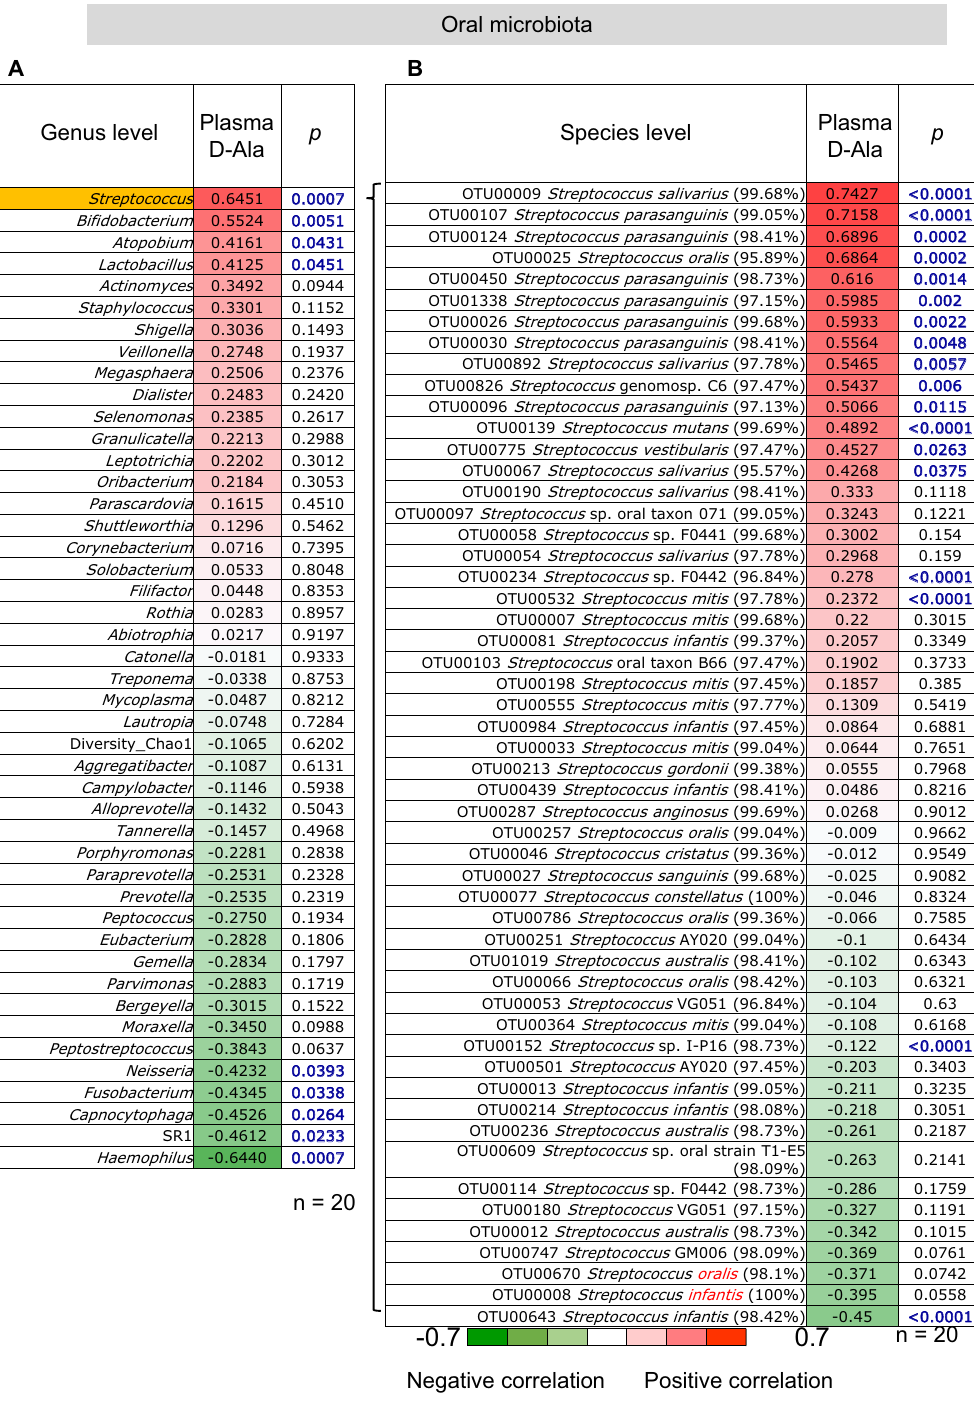
Figure 4. Correlation between the abundance of oral microbiota and plasma d-alanine (D-Ala) levels. ( A ) Correlation between the abundance of oral microbiota at the genus level and plasma D-Ala levels. ( B ) Correlation between the abundance of oral Streptococcus species and plasma D-Ala